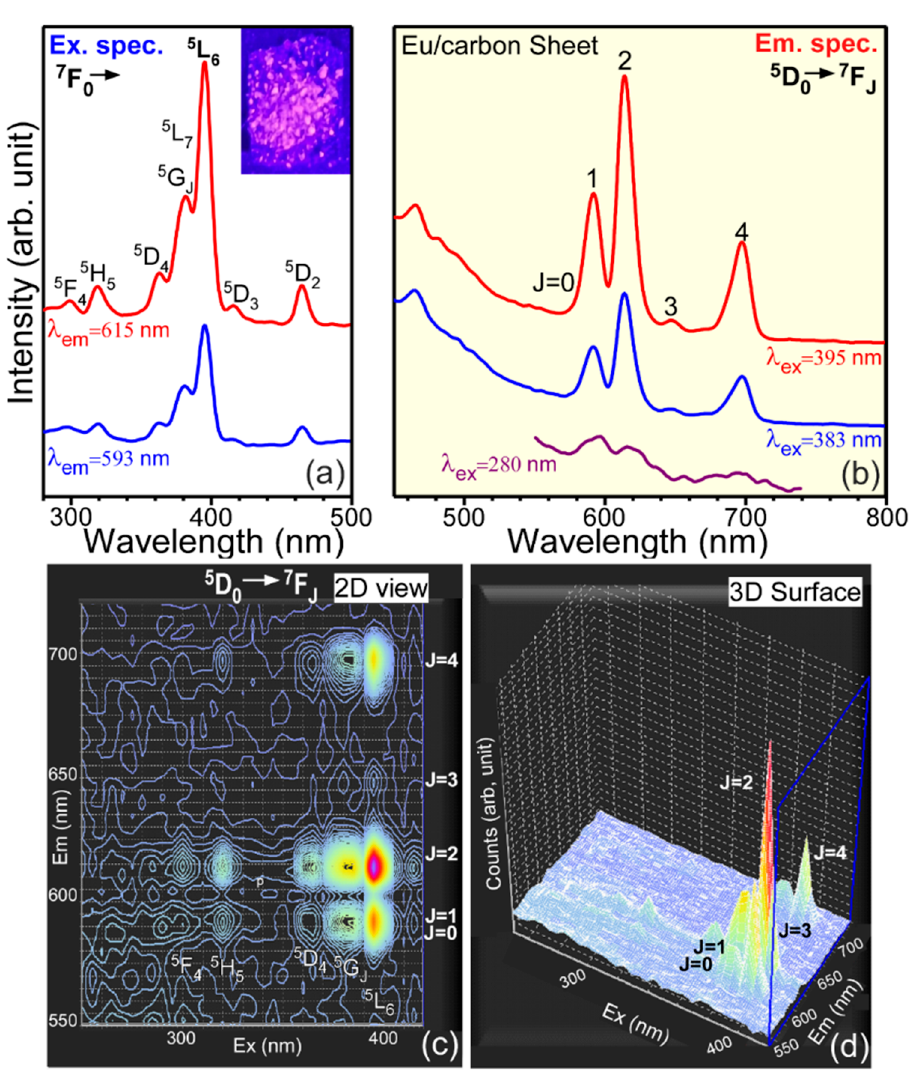
Figure 8. Excitation ( a ) and emission ( b ) spectral profiles for electrodeposited Eu on a carbon sheet, and the corresponding 2D and 3D-photoluminescence contour profiles ( c , d